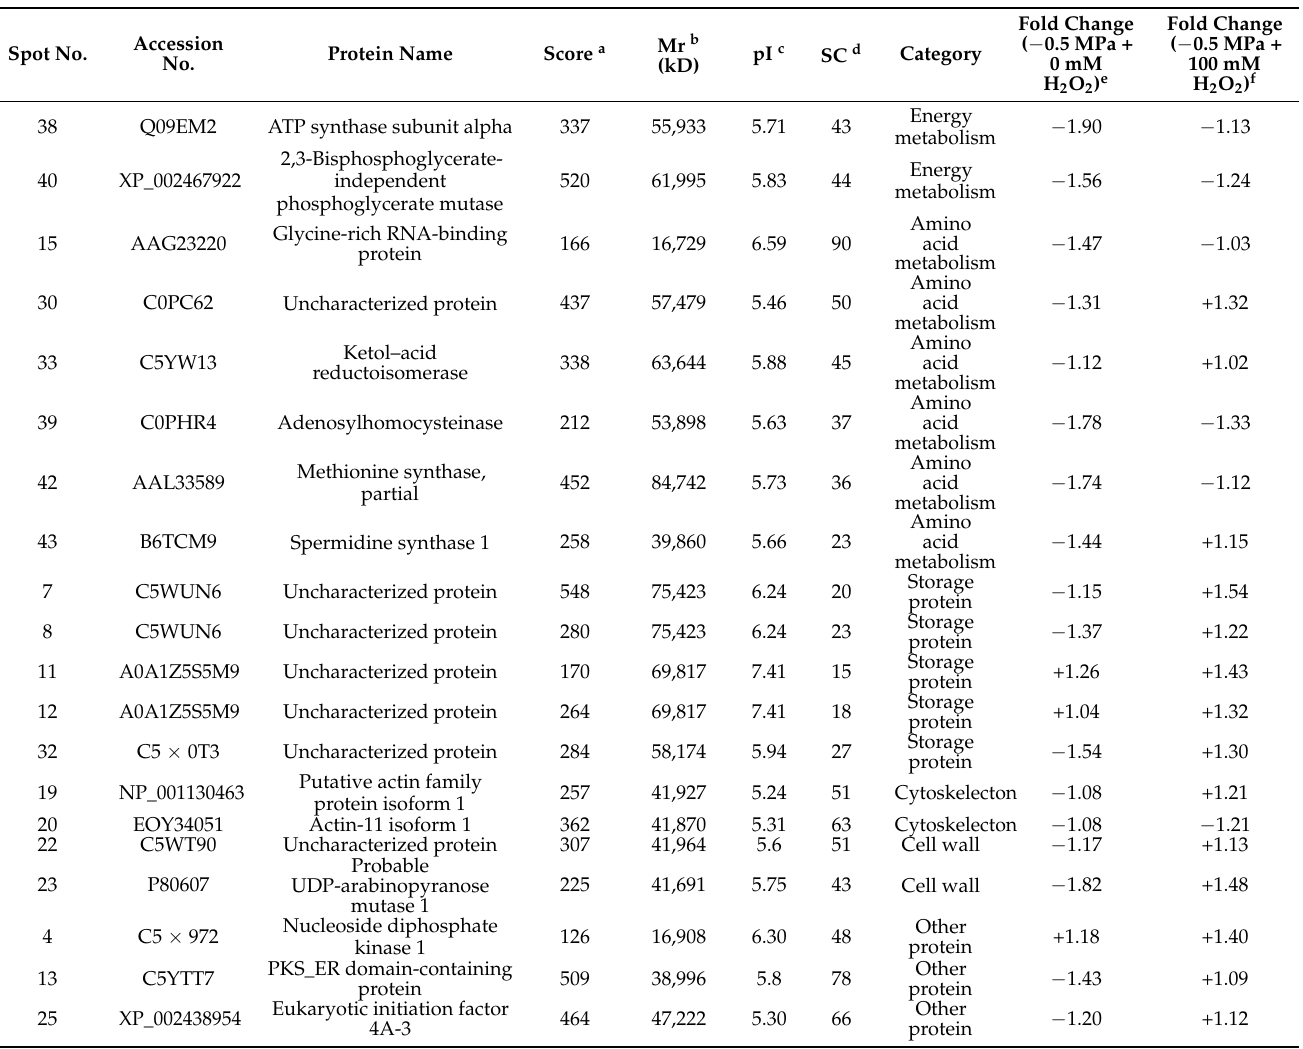
Figure 5. The 2DE-images of seed proteome extracted at 24 h after germination. Protein extracts of embryos from control ( A , 0 MPa + 0 mM H₂O₂) and drought stress-treated sorghum seeds ( B , −0.5 MPa + 0 mM H₂O₂ ), and drought stress and hydrogen peroxide treated seeds ( C , −0.5 MPa + 100 mM H₂O₂) were separated by 2DE (pH 4–7, 12.5% SDS-PAGE).